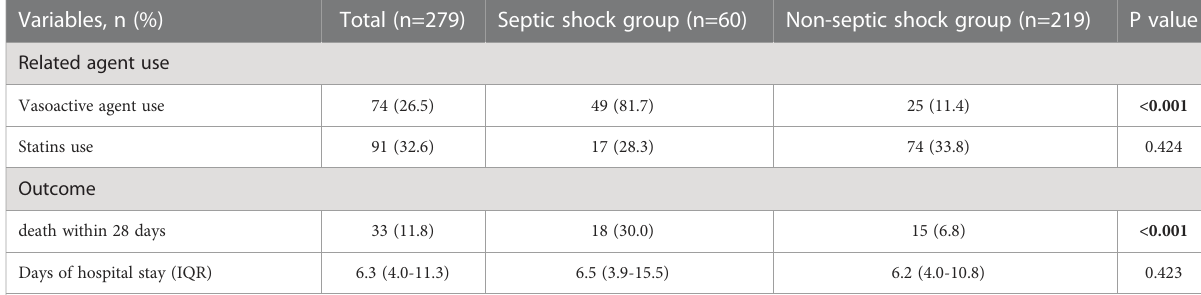
TABLE 4 Predictors for 28-day mortality in septic shock and non-septic shock group by univariate and multivariate analysis.